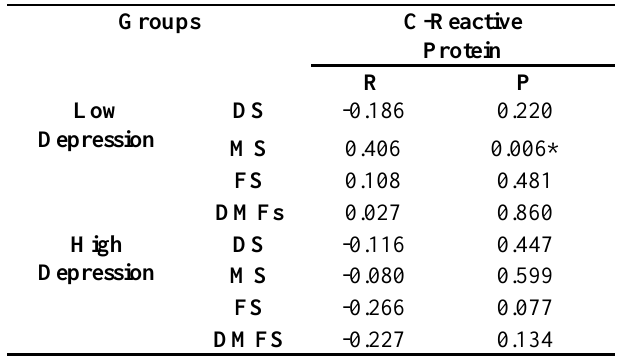
Table 5: Correlation coefficient of caries experience with C-Reactive Protein according to grades of depression.